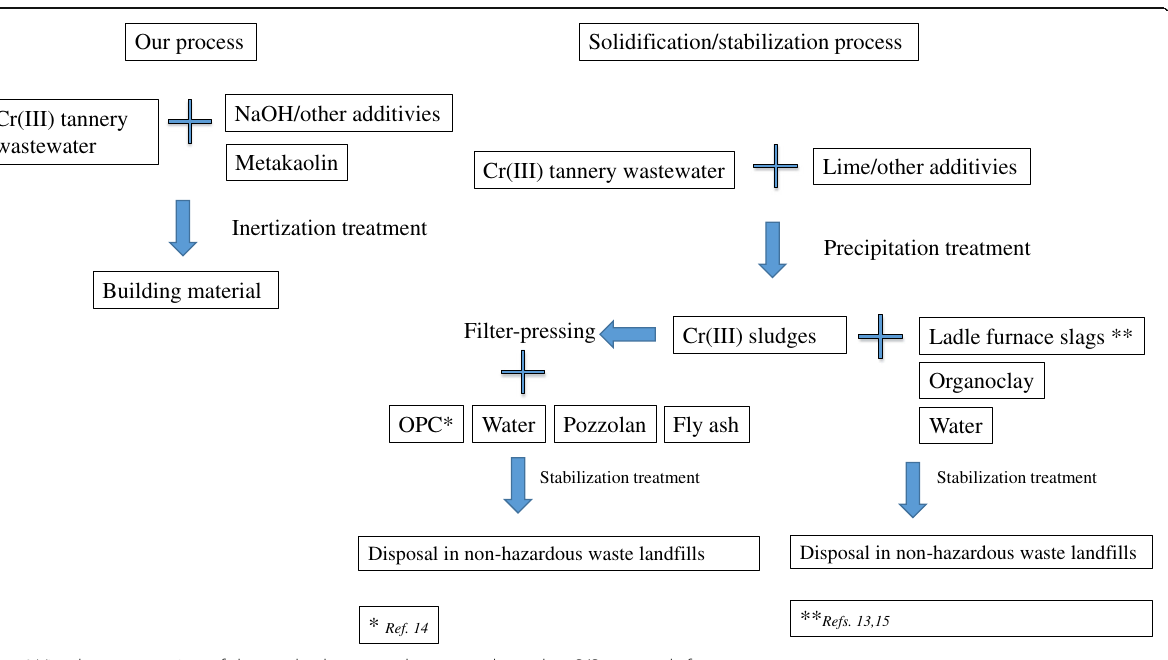
Fig. 6 Visual representation of the method proposed compared to other S/S approach for tannery